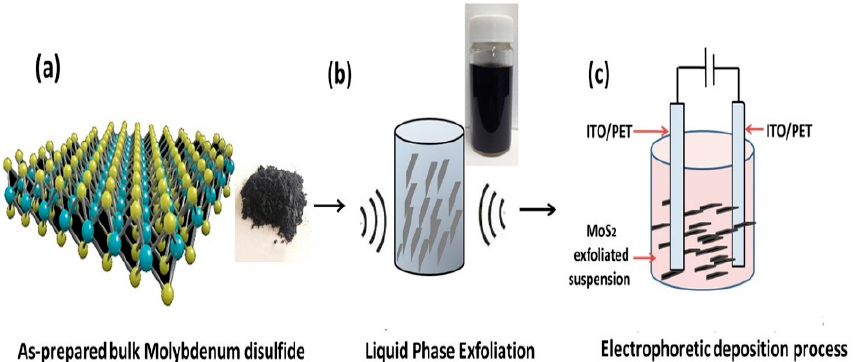
Figure 1. Schematic diagram of: ( a ) MoS 2 bulk material, ( b ) preparation of 2D MoS 2 nanosheets using the liquid phase exfoliation process, and ( c ) preparation of PET/ITO/MoS 2 via Electrophoretic deposition method.